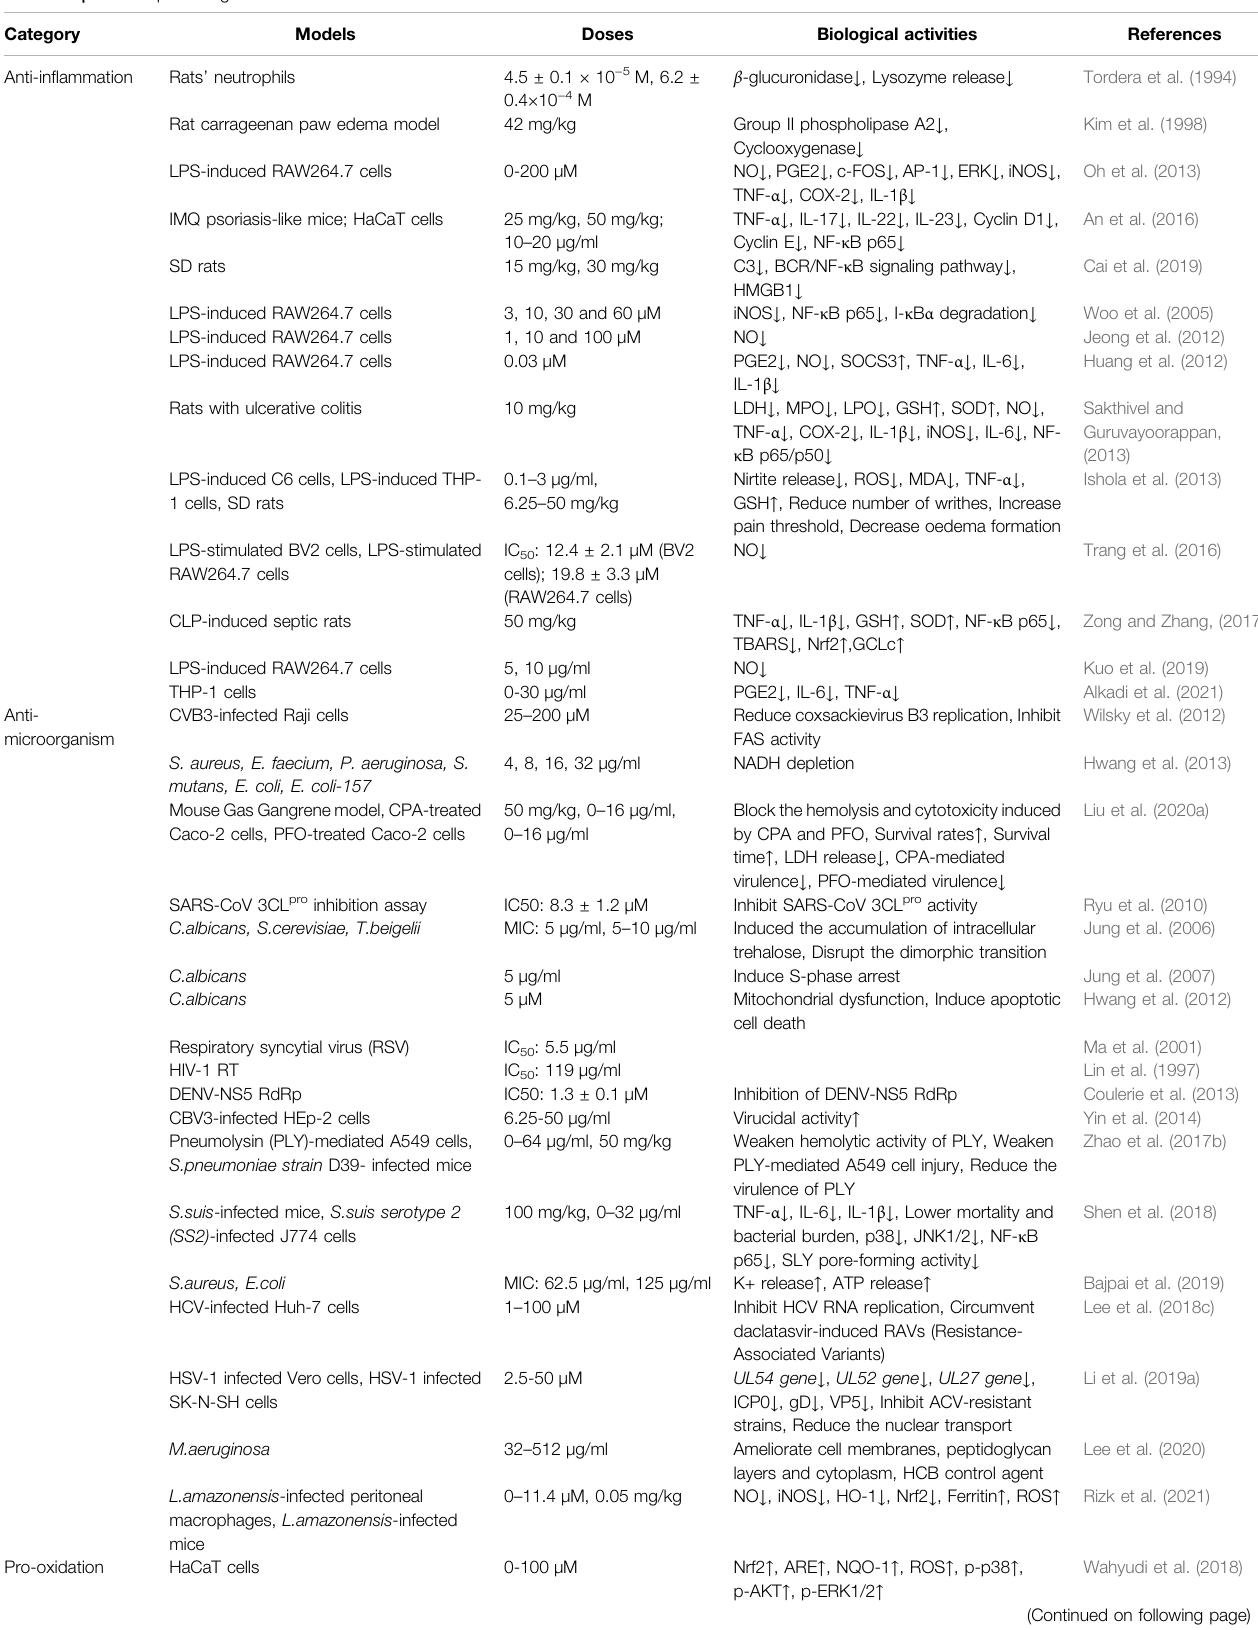
TABLE 1 | The mutiple biological activities of